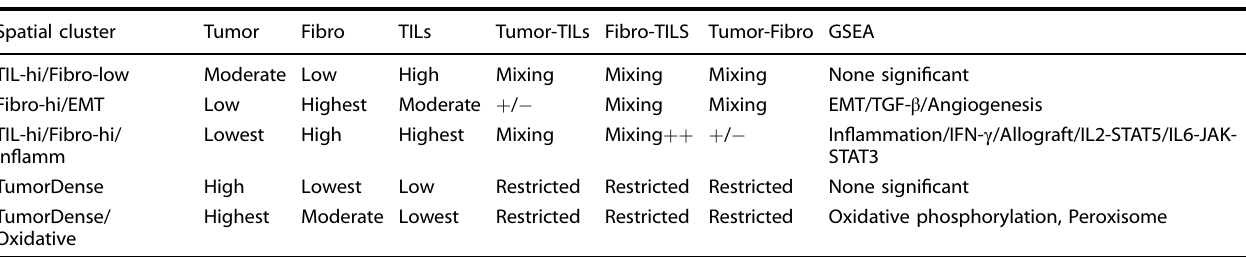
Table 1. Summary Table of Spatial